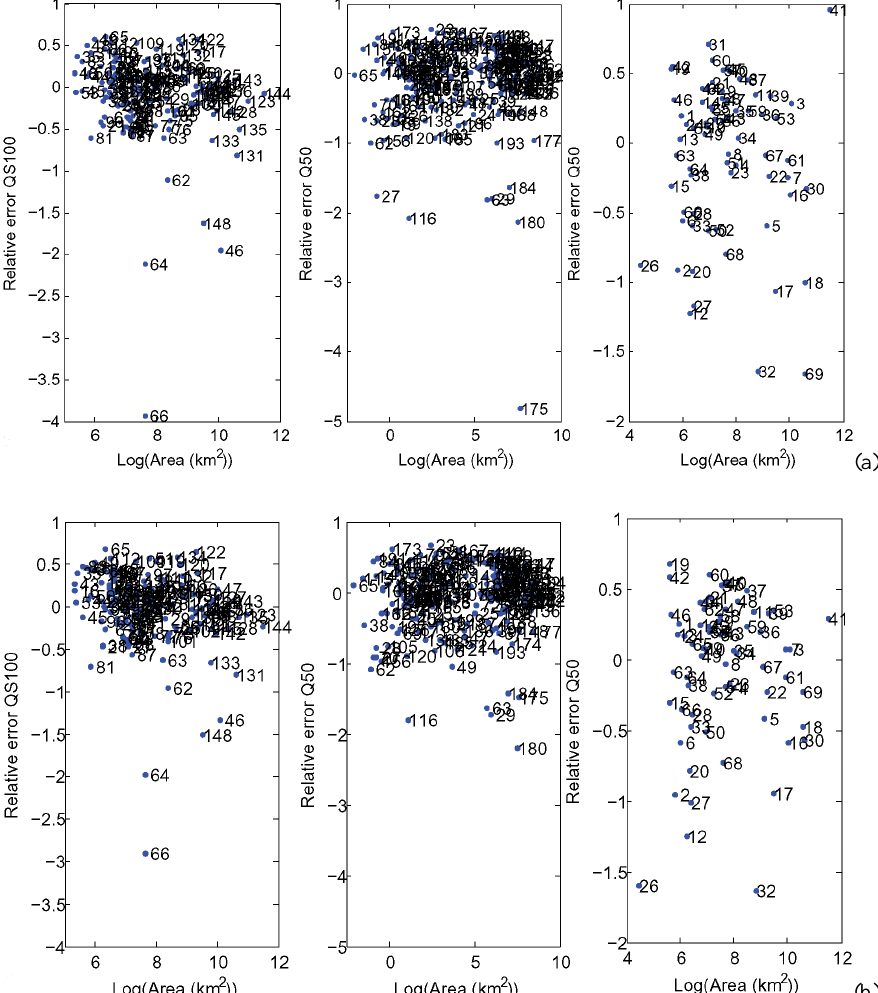
Fig. 8. Relative quantile errors using (a) ϕ CCA and (b) ϕ G . The first column illustrates the error of QS100 in southern Quebec, the second column illustrates the errors of Q50 in Arkansas and the third column illustrates the errors of Q50 in Texas.